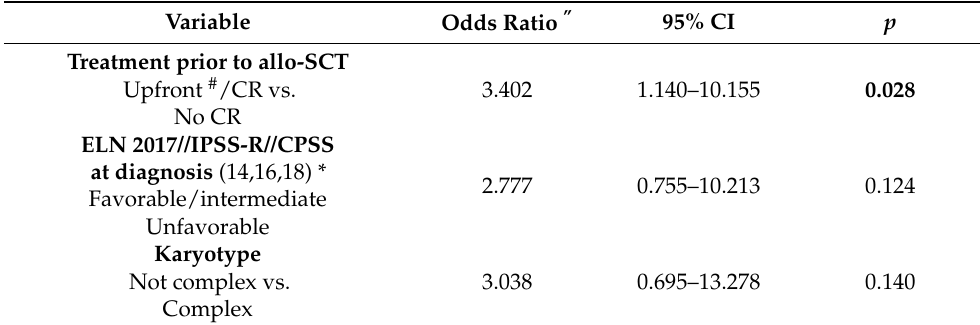
Table 2. Predictors for late relapse—multinominal logistic regression. Variable Odds Ratio ” 95% CI p Treatment prior to allo-SCT Upfront # /CR vs. No CR at diagnosis (14,16,18) * Favorable/intermediate Unfavorable